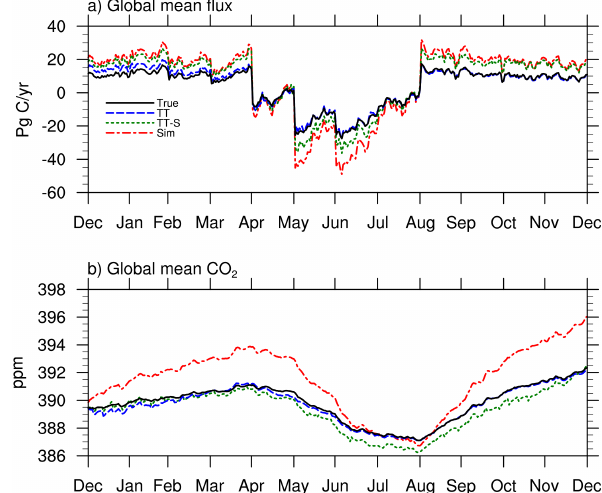
Figure 4. Time series of the global mean (a) CO 2 surface fluxes and (b) CO 2 concentrations from the “truth”, simulations, TT-S (the simplified version of Tan-Tracker) and TT (Tan-Tracker) assimila- tions from 1 January to 31 December